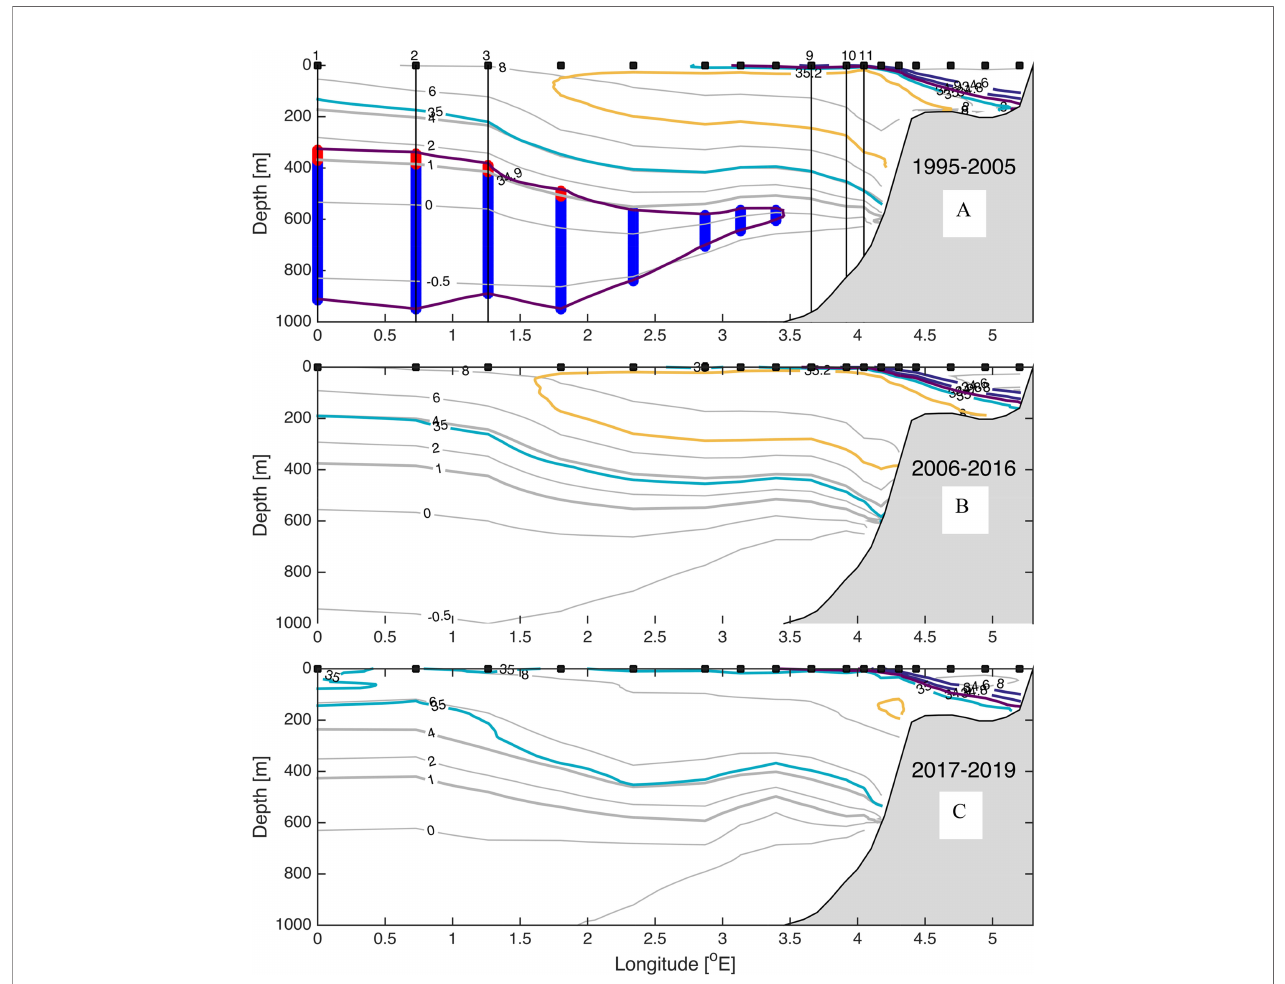
FIGURE 4 | (A – C) Mean temperature and salinity for the Svinøy section for the periods (A) 1995-2005, (B) 2006-2016, and (C) 2017-2019. Colors are for salinity showing 34.9 (purple), 35.0 (light blue) and 35.2 (yellow) isohalines, and gray show isotherms -0.5, 0, 1,., 8°C. Vertical lines show nutrient data used in Figures 8 , 9 stations 1-3 represent the western edge of the Norwegian Atlantic Front Current, and stations 9-11 represent the “ core ” Atlantic water. Thick vertical lines indicate Arctic Intermediate Water (blue) and Modi fi ed East Icelandic Water (red). Black squares show positions of the